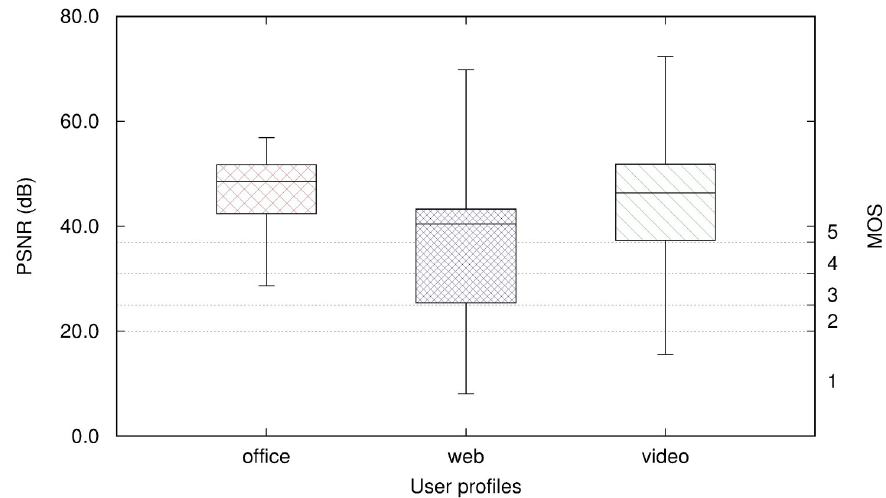
Fig 8. Boxplot of PSNR for three user profiles in Amazon